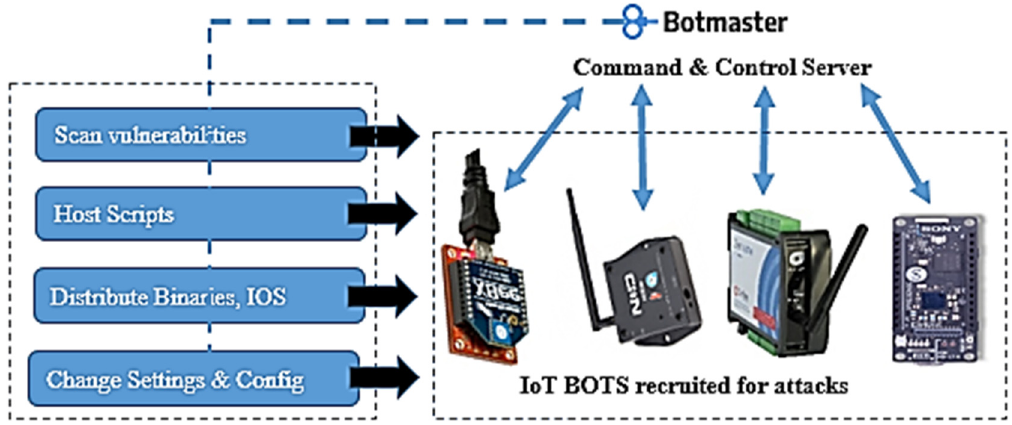
Figure 7. Command and control server attacks.